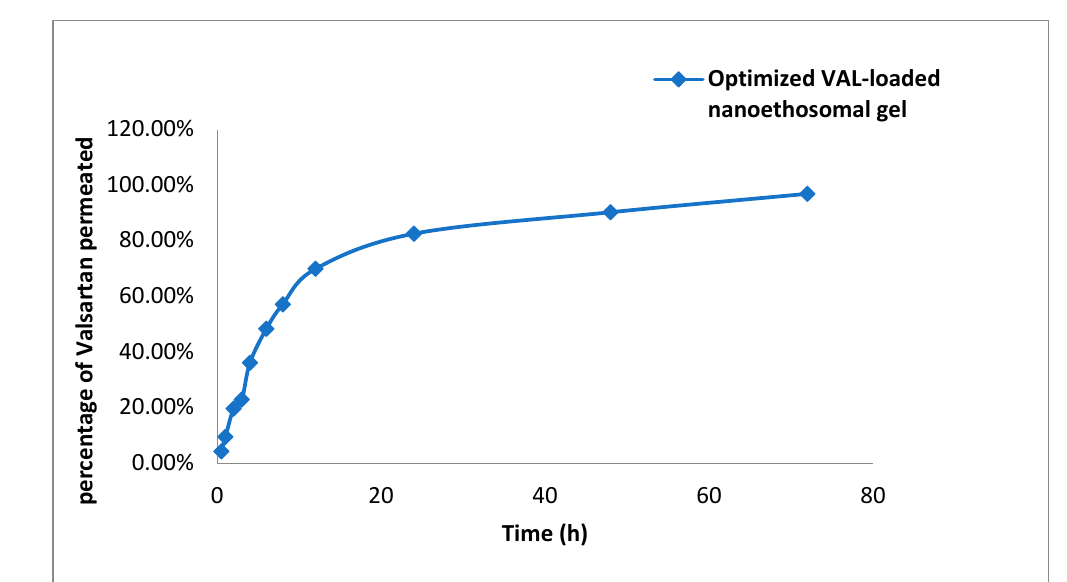
Figure 6. Ex vivo graph of valsartan ethosomal gel (mean ± S.D, n = 3).